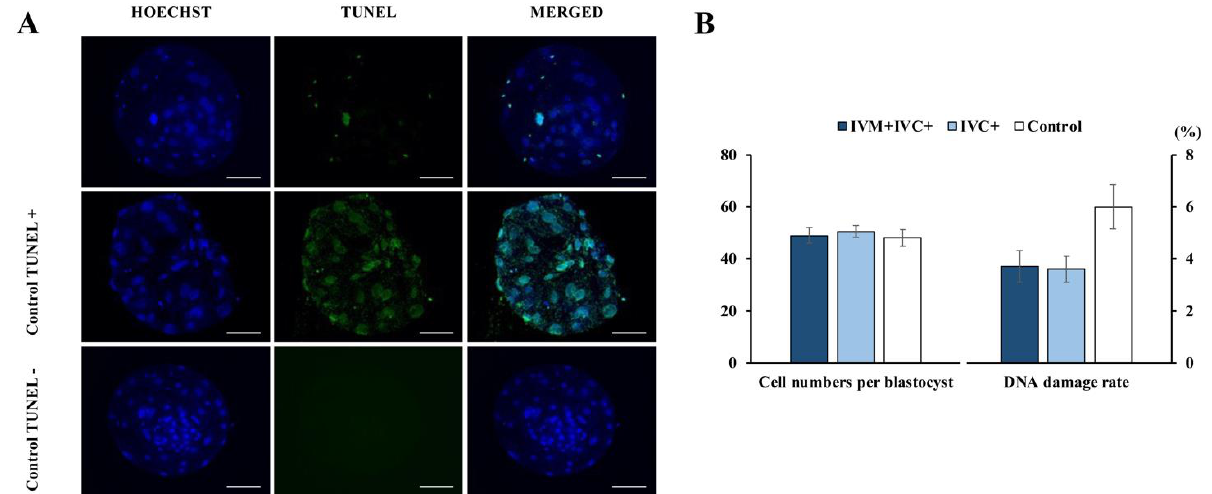
Figure 6. Detection of DNA damage in in vitro-produced Day 7 blastocysts. ( A ) Representative fluorescence images of the TUNEL assay. Hoechst (blue) and TUNEL (green) staining indicate the total cells and the cells with DNA damage, respectively. Scale bar: 50 µm. ( B ) Effects of melatonin on DNA damage rates in blastocysts. Melatonin (1 nM) was added to both the maturation and culture media (IVM + IVC+ group; n = 31) or only to the culture medium (IVC+ group; n = 30). Oocytes matured, fertilized, and cultured in media without melatonin supplementation were used as controls ( n = 26). Data are expressed as the mean ± SEM (three replicates).